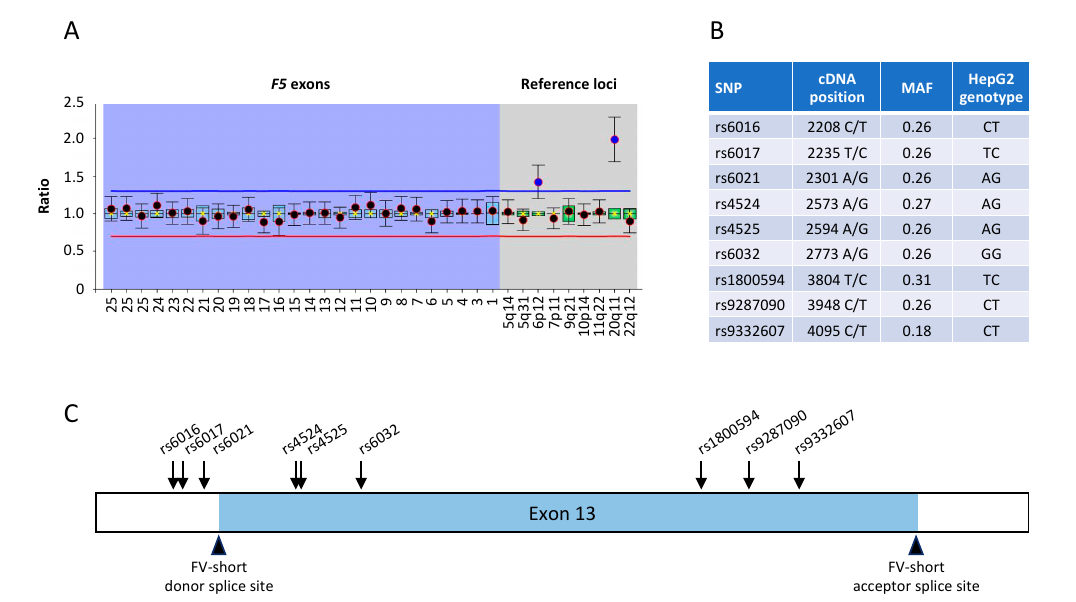
Figure 2. Characterisation of the F5 gene in HepG2 cells. ( A ) MLPA analysis of the F5 gene in HepG2 cells. The normalised copy number is plotted for individual F5 exons (purple background) and for reference genes located on different chromosomes (grey background). A ratio of ~1 indicates a normal copy number (n = 2), whereas ratios above the blue line or below the red line indicate copy numbers >2 or <2, respectively. ( B ) Common SNPs identified in F5 exon 13 in the genomic DNA of HepG2 cells; MAF: minor allele frequency. ( C ) Positions of the identified F5 exon 13 SNPs relative to the FV ‐ short ‐ specific donor and acceptor splice sites.